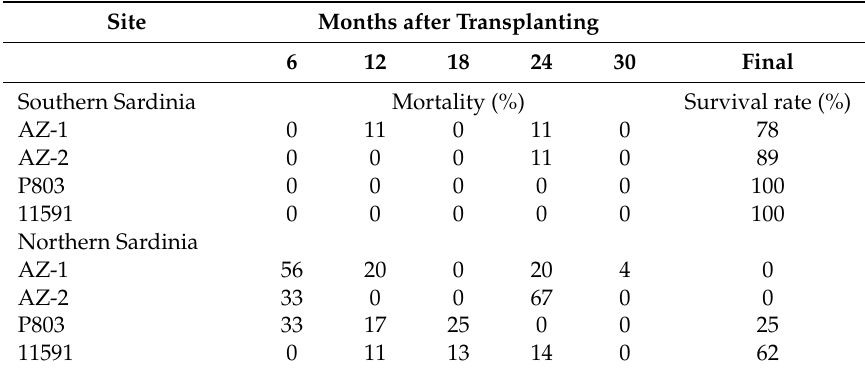
Table 1. Plant mortality and final survival rate in guayule lines at 30 months from transplanting at the two sites.